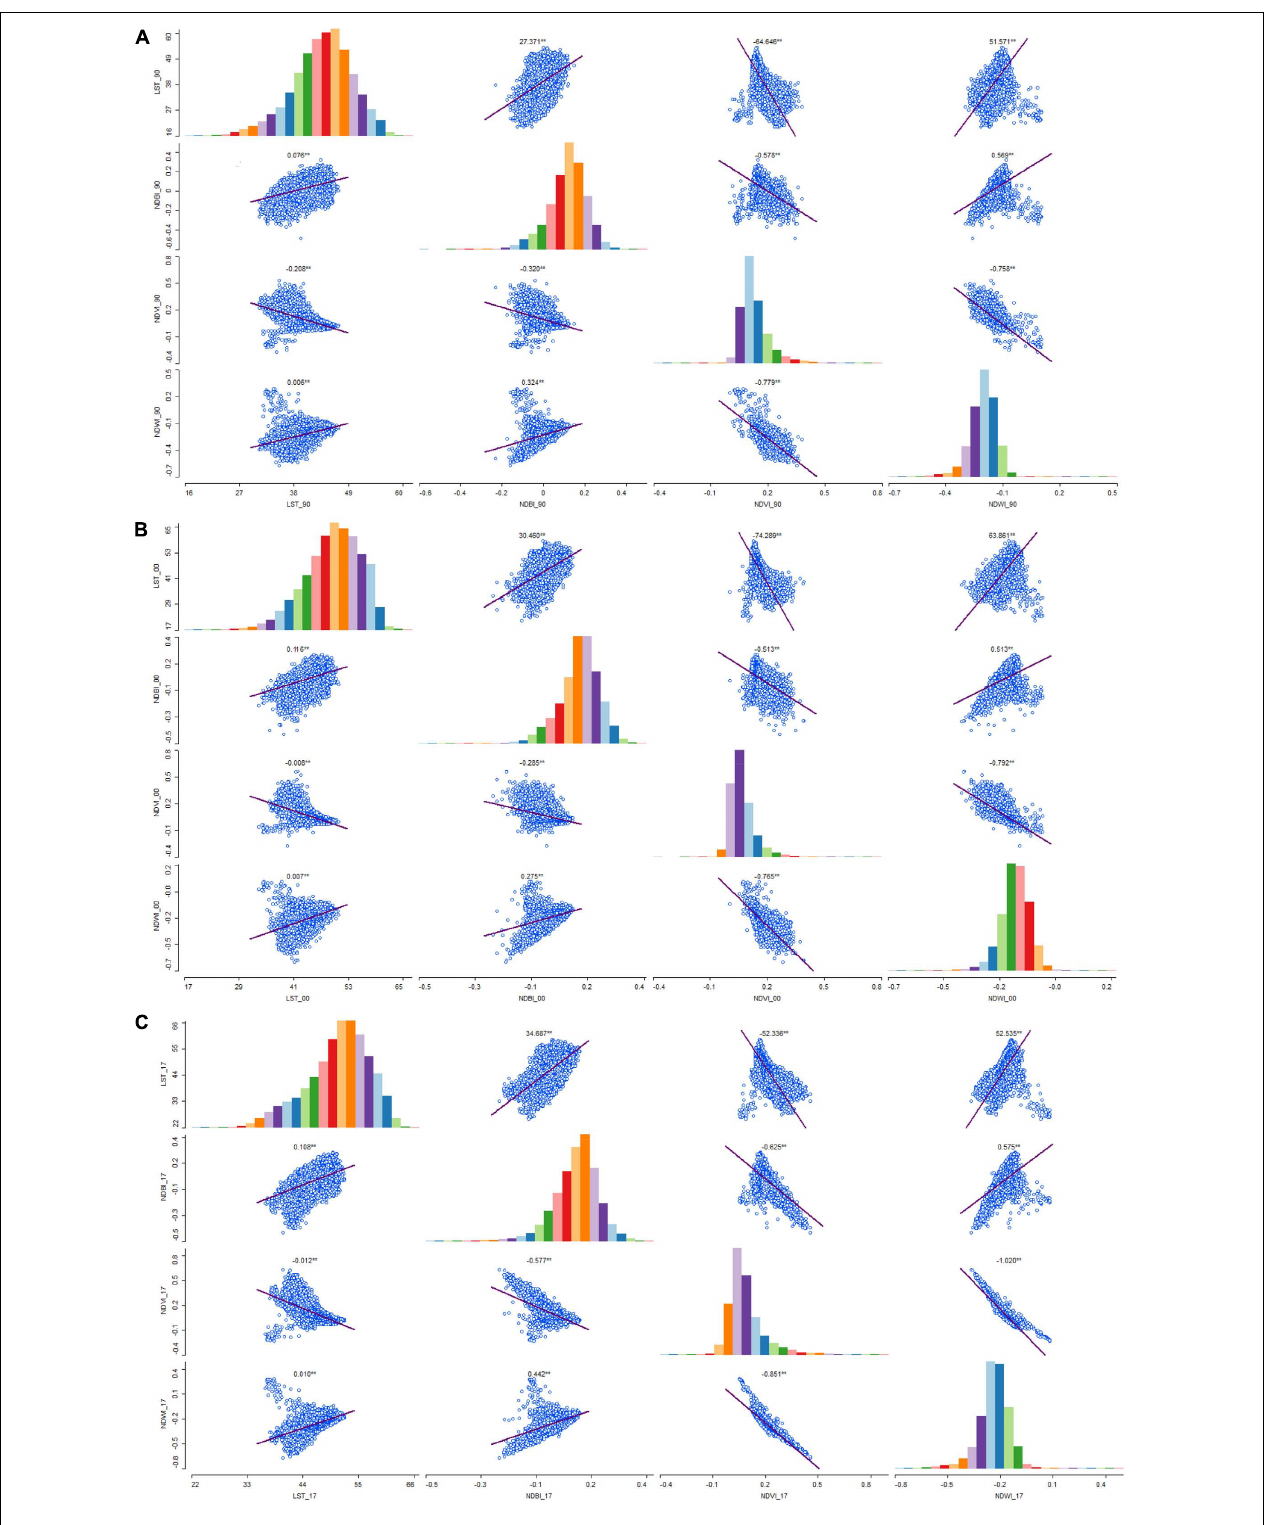
FIGURE 4 | The correlation coefficient analysis between LST and urban biophysical parameters for (A) 1990, (B) 2000, and (C) 2018.